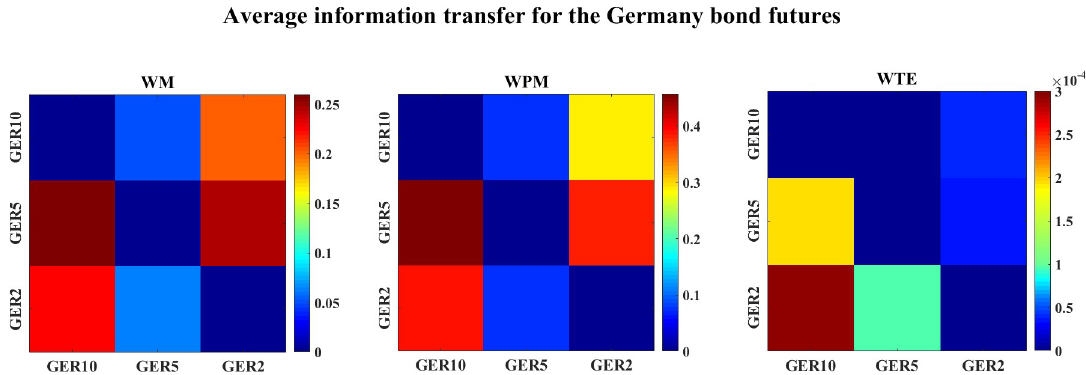
Fig 29. The color-map for the average information transfer between the Germany bond futures. The three color-graphs present the color-map of the average WM (left), WPM (middle) and WTE (right) information transfer between the Germany bond futures. The direction of information flow is read from the row channel to the column channel for each lattice.